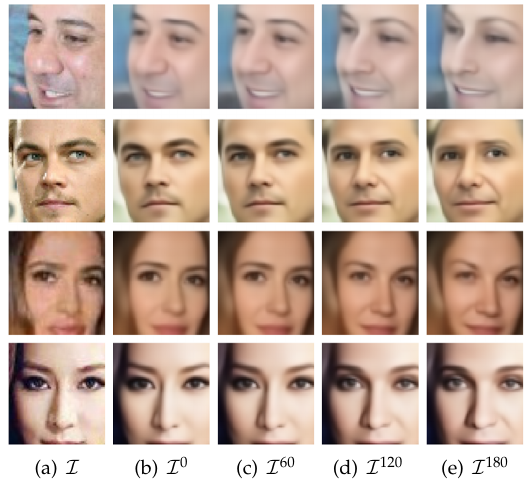
Figure 4. Facial de-identification examples from the proposed method. From left to right: input facial images and transformation results rotated on a hyper-plane by { 0,60,120,180 } degrees,